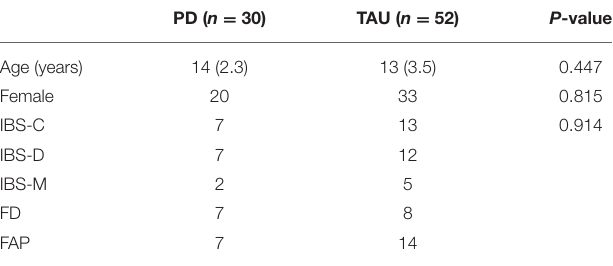
TABLE 1 | Demographics including age, gender, and primary FAPD